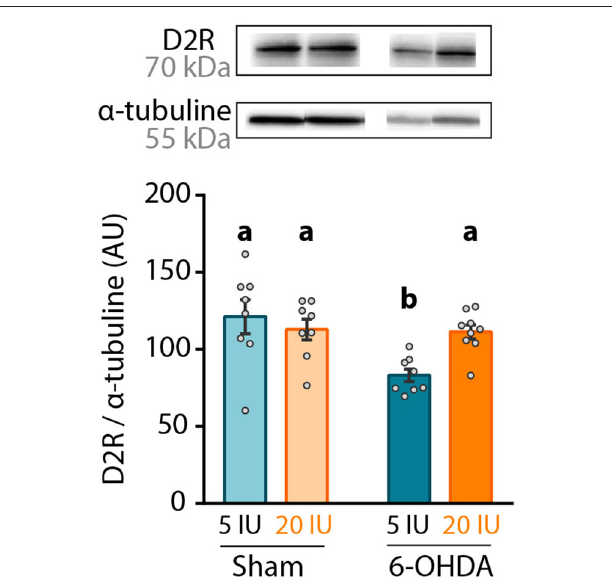
FIGURE 6 | Impact of 6-OHDA lesion and dietary vitamin A on D2R protein levels in the striatum. Representative western blot for dopamine D2 receptor (D2R) in striatum homogenates (upper inset) and quantification (graph). Protein expression levels were normalized with α -tubuline for each sample. Results are expressed as means ± SEM with individual data points. a, b: values significantly different ( p < 0.005). Details of the statistical analysis are summarized in Table 3